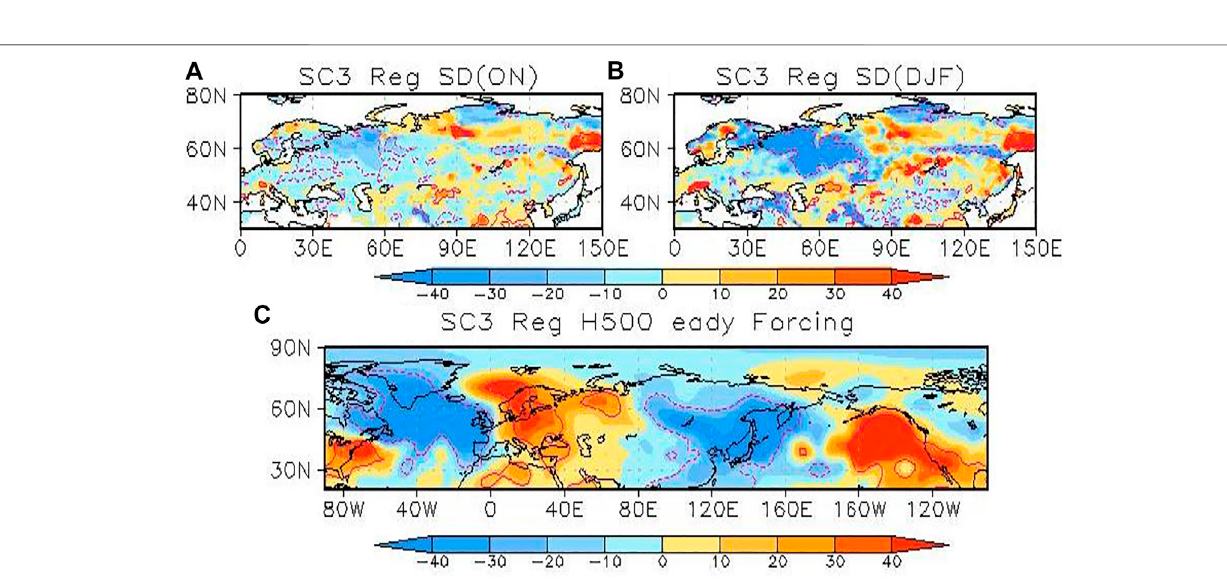
Frontiers in Earth Science |